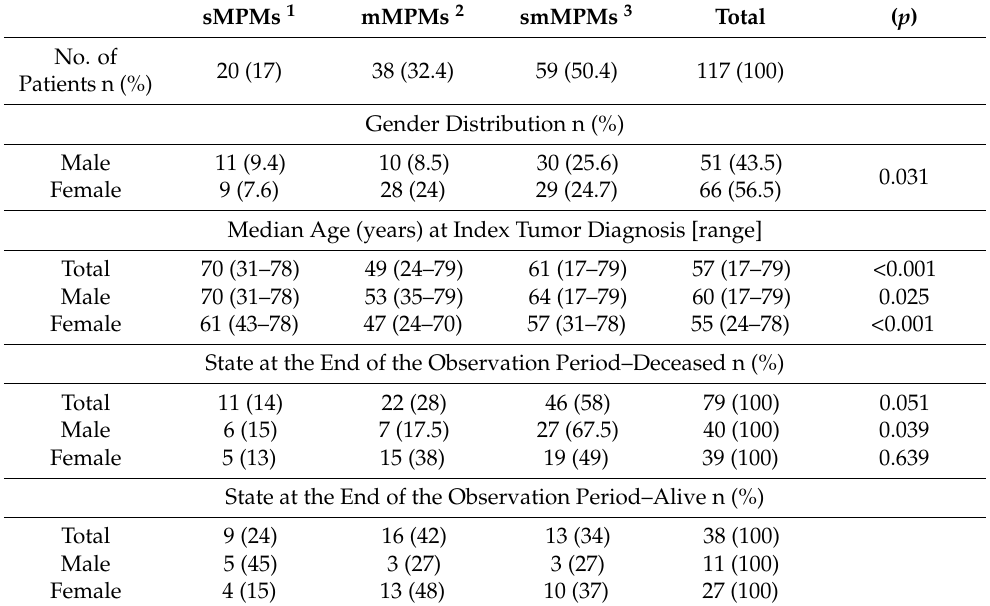
Table 1. Patient characteristics.